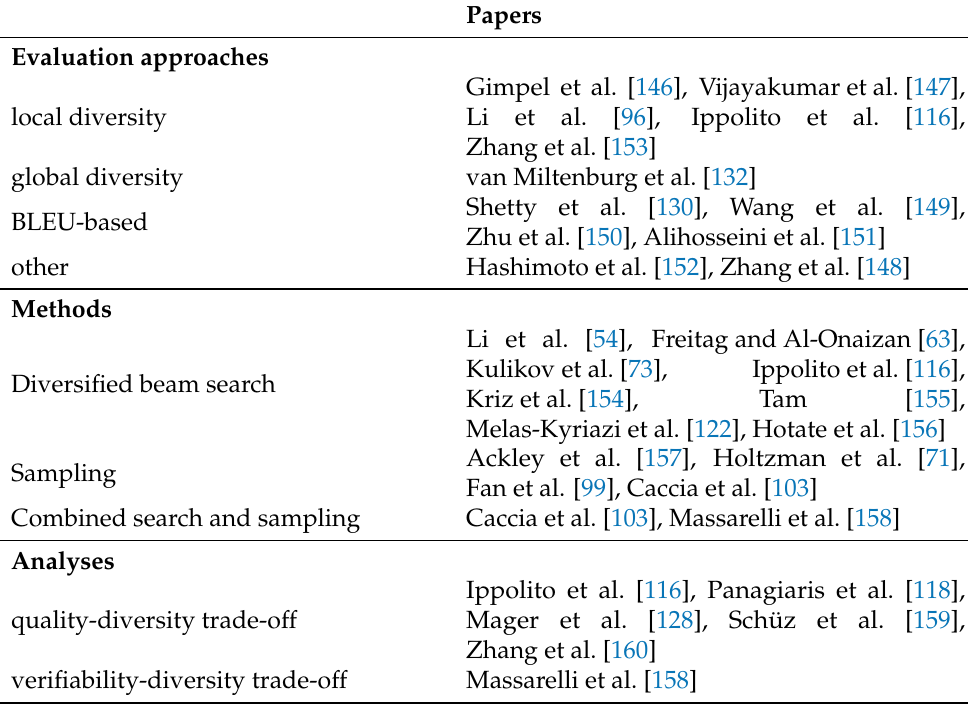
Table 4. Overview of papers on diversity-oriented decoding reviewed in Section 4.